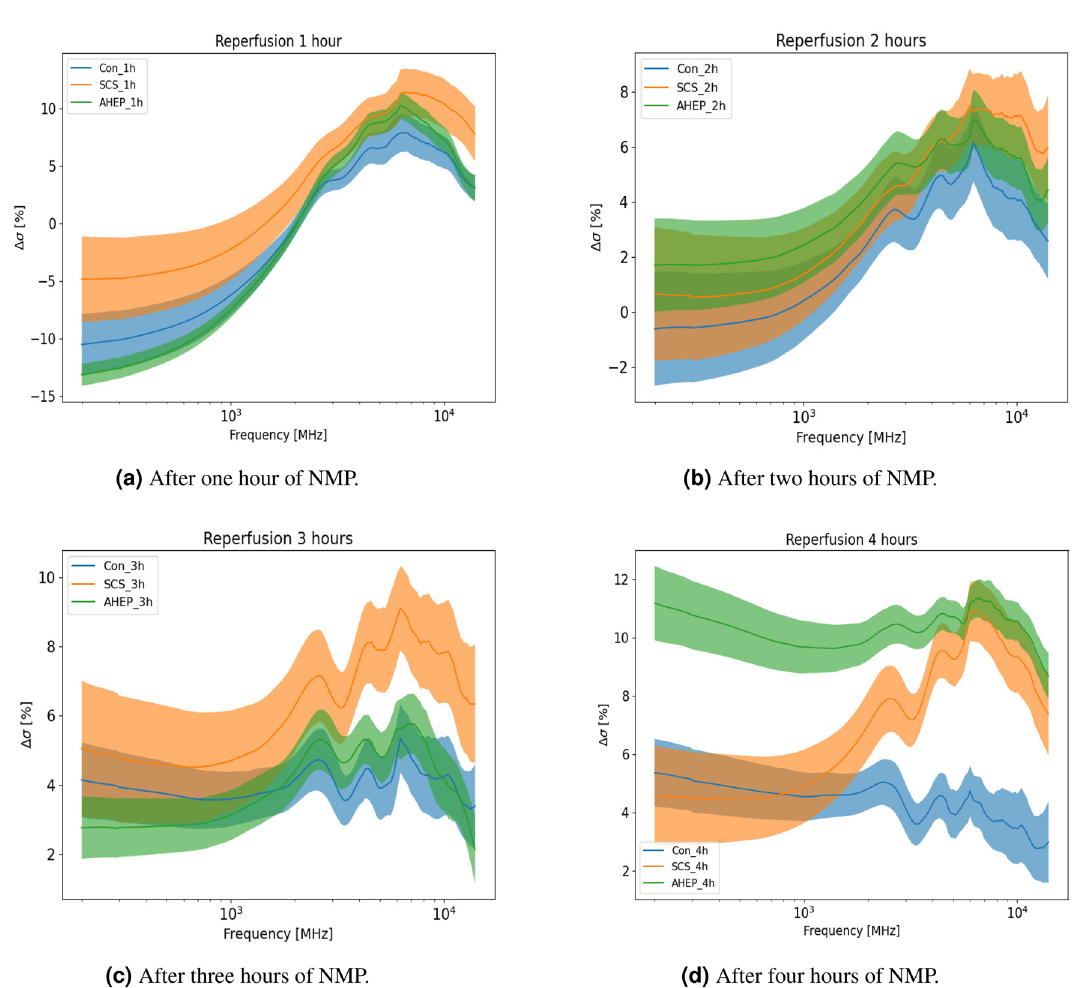
Figure 2. Relative change in the conductivity for three groups as function of frequency displayed with mean and standard error calculated with equation (2). Frequency range used was 200 MHz–14 GHz (plotted in a logarithmic scale on the x-axis). N = 7 for each of the